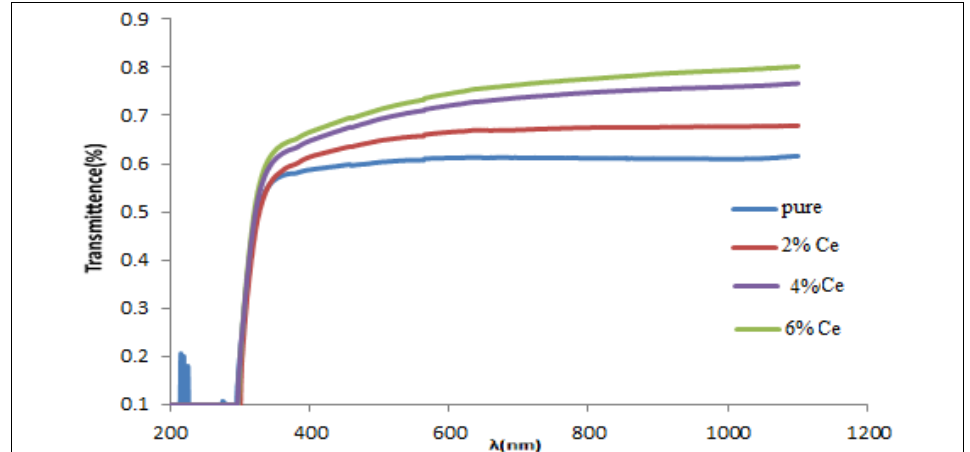
Fig. 11: Transmittance spectra of CdO thin films at different concentration of Ce.